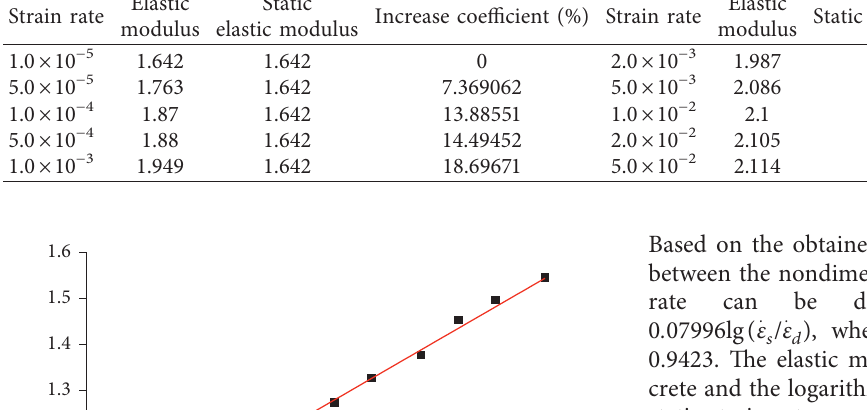
Table 4: Elastic modulus of lightweight aggregate concrete under various strain rates (MPa). Strain rate